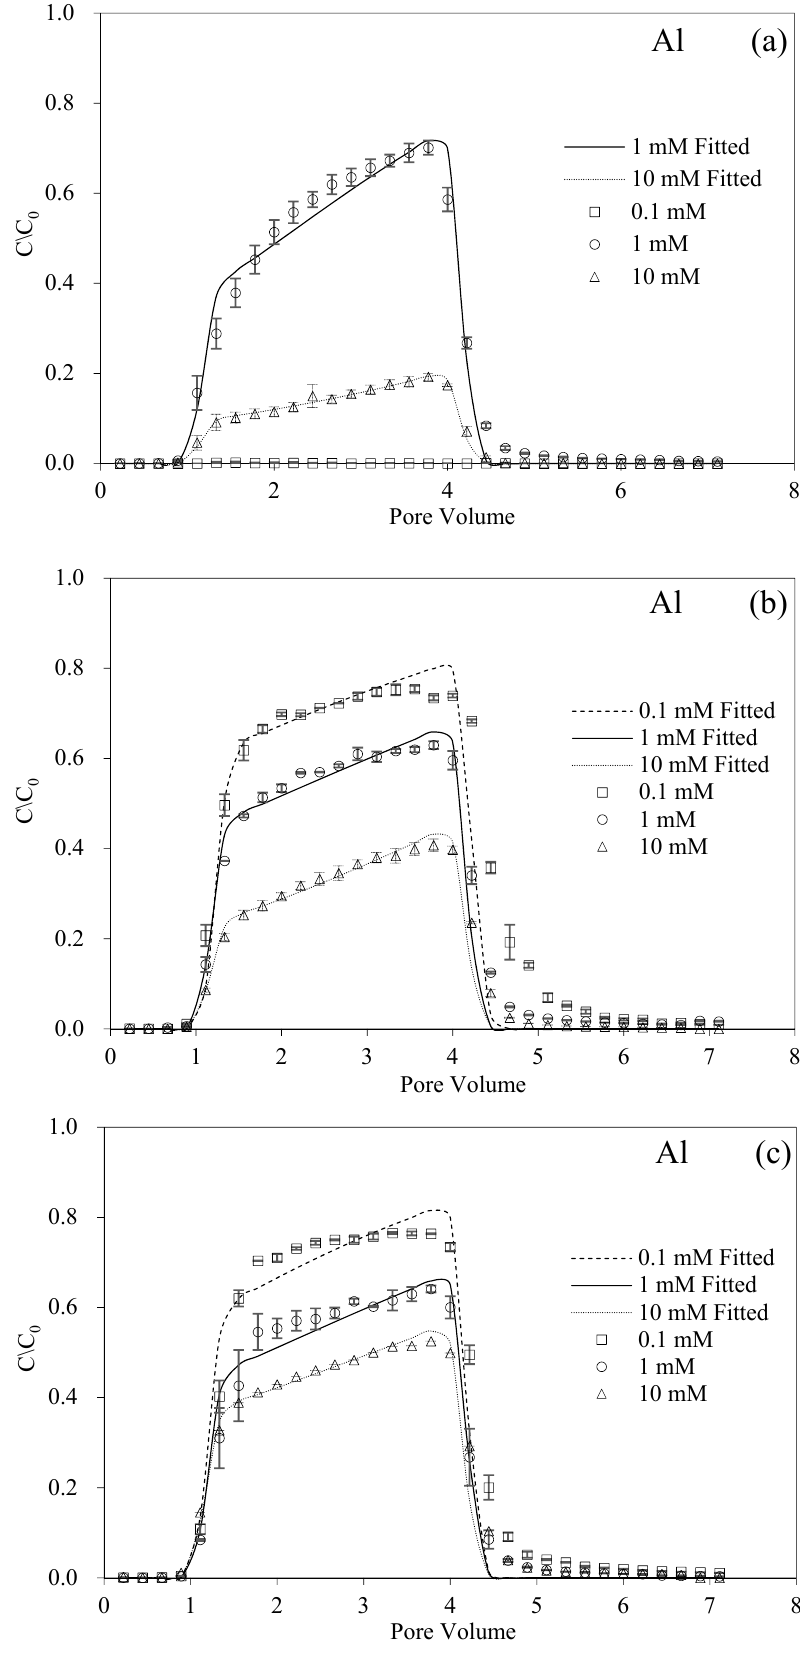
Figure 4. Breakthrough and fitting curves of BMBC at different ISs of Al with 0 ( a ), 1 ( b ), and 5 ( c ) mg L − 1 HA.